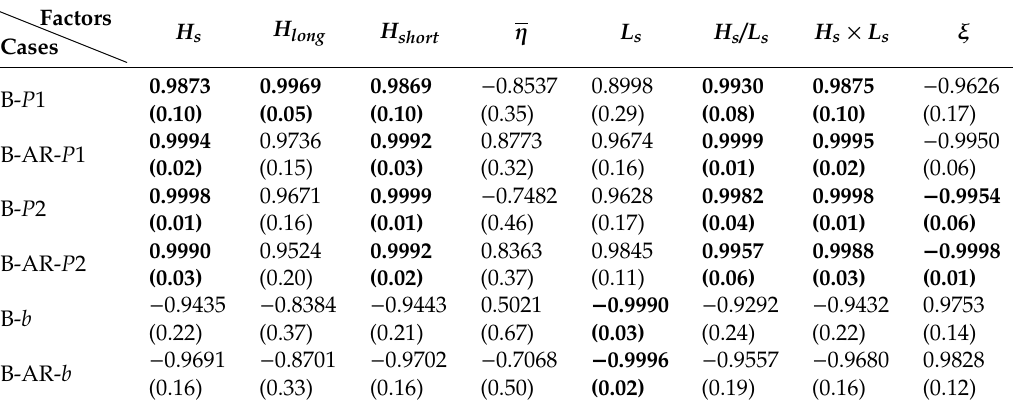
Table 9. The Pearson’s linear correlation coe ffi cients of hydrodynamic factors and model parameters under irregular waves with significant level in parentheses ( H s is significant wave height at W6, and L s is calculated by local water depth and peak period at W6; bold format indicates correlation coe ffi cients with relatively low significant level meaning significant